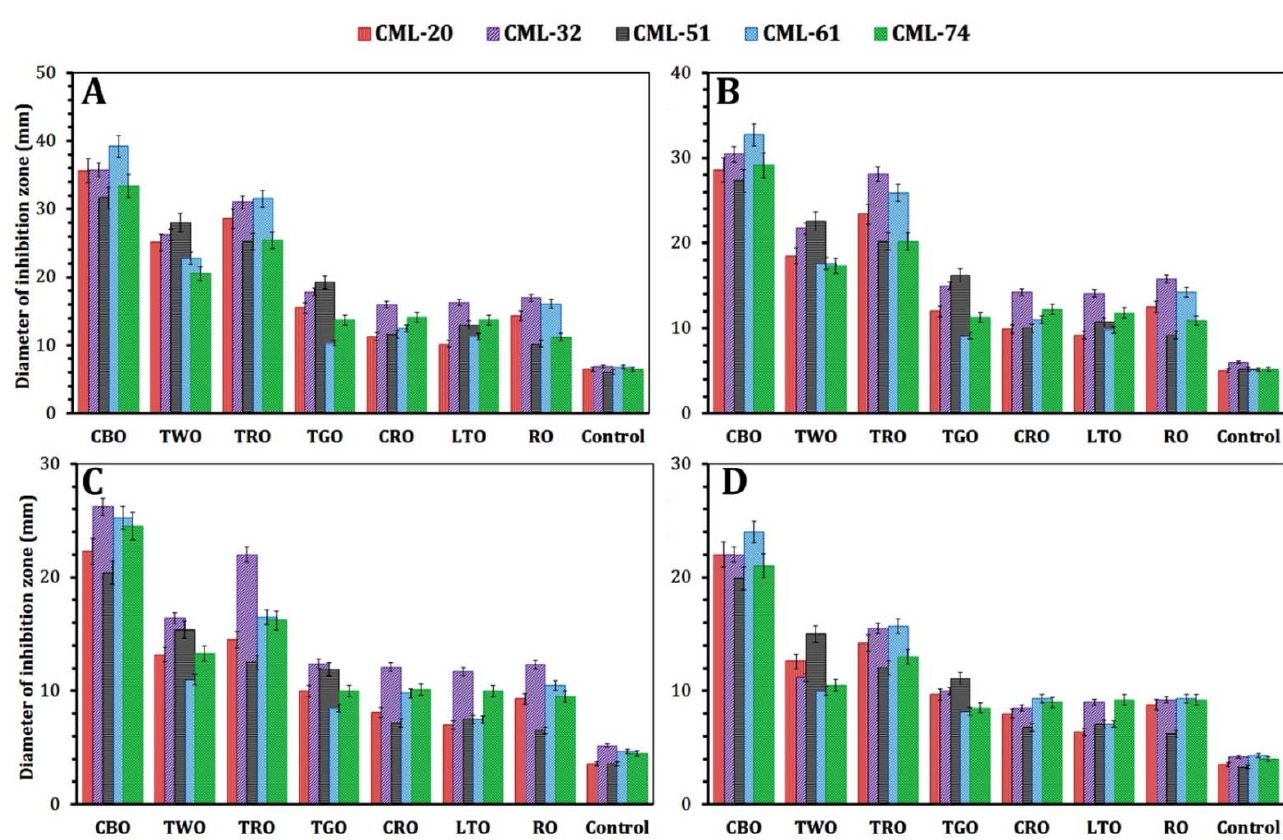
Figure 4. Antilisterial efficiency of different concentrations of essential oils against the selected L. monocytogenes strains: inhibitory effect at 0.5% ( v / v ) ( A ), 0.25% ( v / v ) ( B ), 0.15% ( v / v ) ( C ), and 0.1% ( v / v ) ( D ).